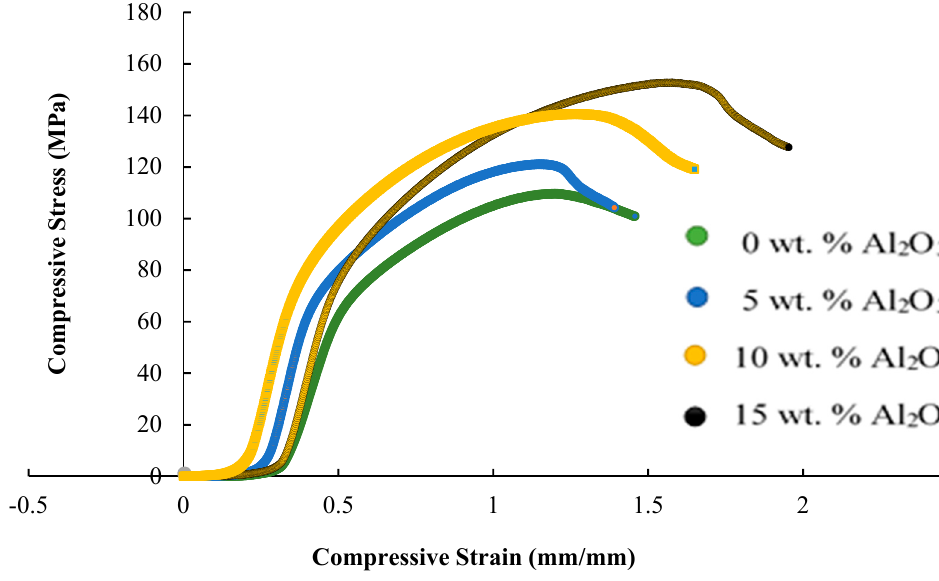
Figure 5. Stress–strain curve for representative samples with different composition of alumina.